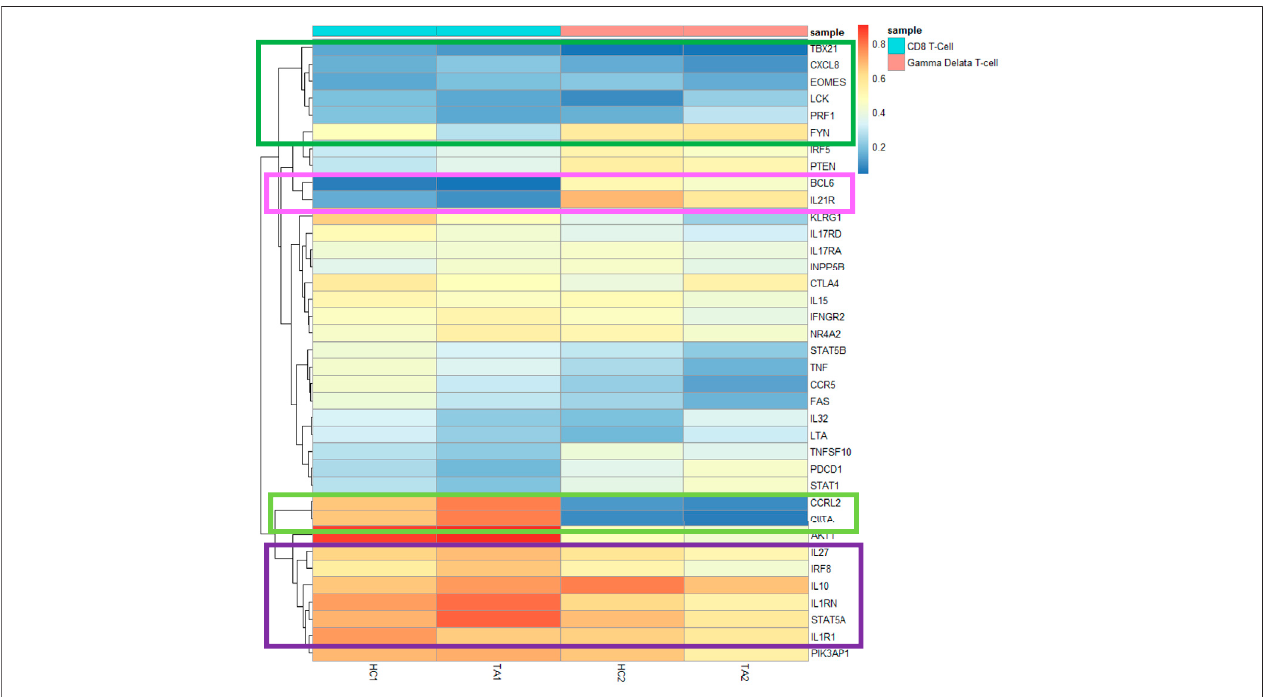
FIGURE 5 | Heatmap plot showing hypomethylated genes in CD8 T cells and γδ T cells of TA patients as compared with healthy controls. BCL6 and IL21R were hypomethylated genes in only CD8 T-cells (marked in pink colour box). CCRL2 and CIITA genes were hypomethylated in only γδ T-cells (marked in light green colour